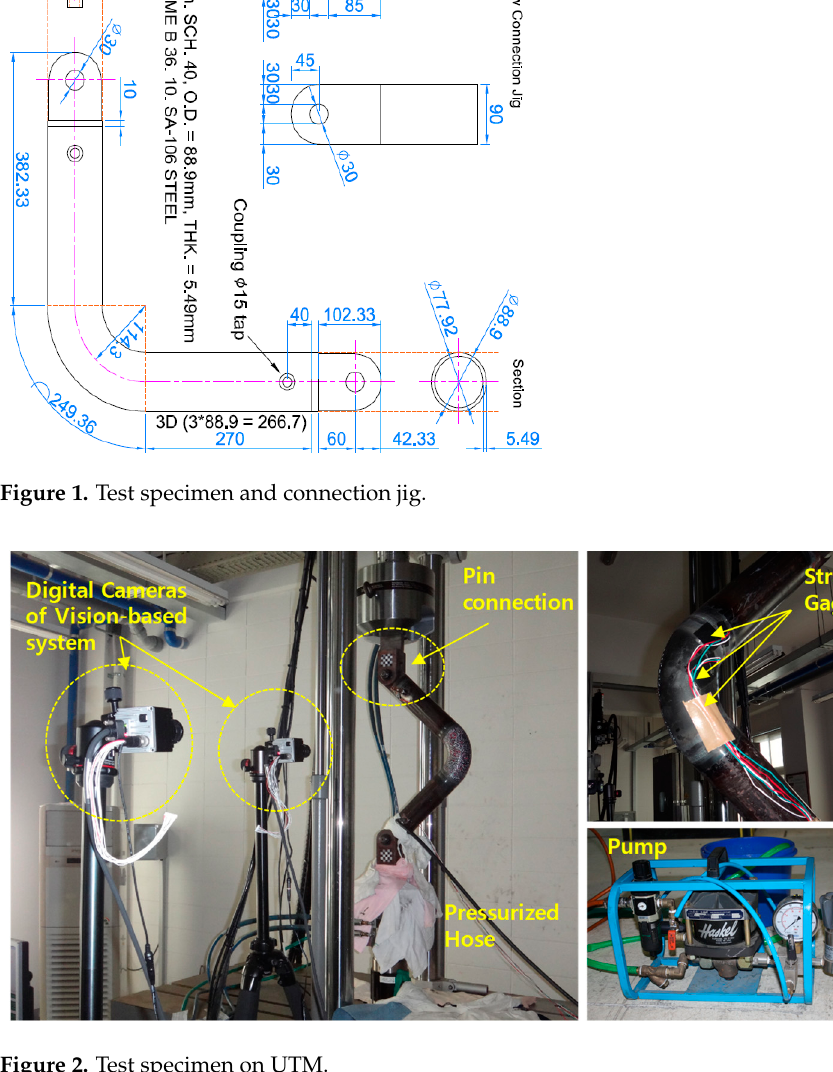
Figure 2. Test specimen on UTM.